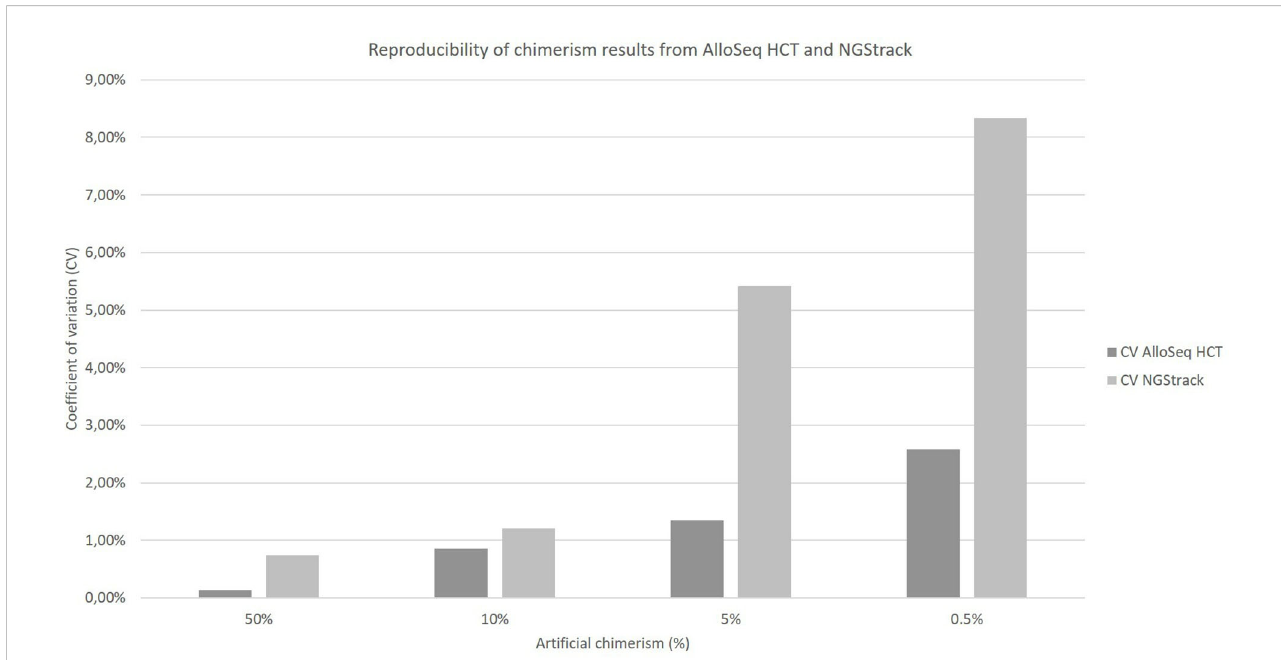
FIGURE 6 Reproducibility of chimerism results from AlloSeq HCT and NGStrack. Each chimerism percentage (50%, 10%, 5%, 0.5%) was tested on at least three different experiments to calculate the coef fi cient of variation of each